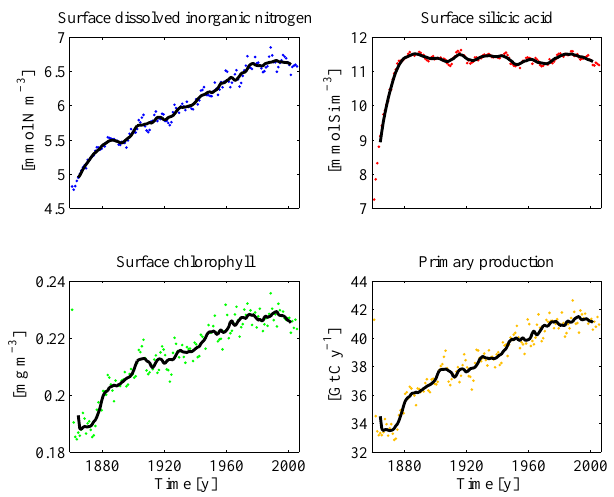
Fig. 34. Globally averaged surface dissolved inorganic nitrogen ( top left ), surface silicic acid ( top right ), surface chlorophyll ( bottom left ) and integrated primary production ( bottom right ). Solid black lines are annual averages/integral; individual points are individual months. Note that individual monthly primary production values have been normalised so that they appear on the same scale as an- nual integrals.